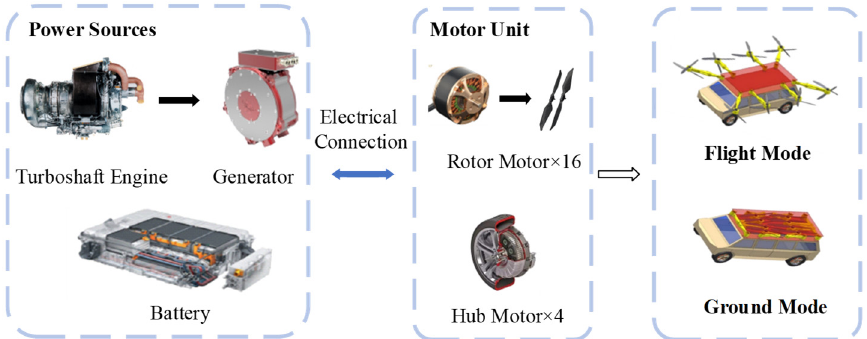
Figure 1. Structure of the studied HEAGV and powertrain system.